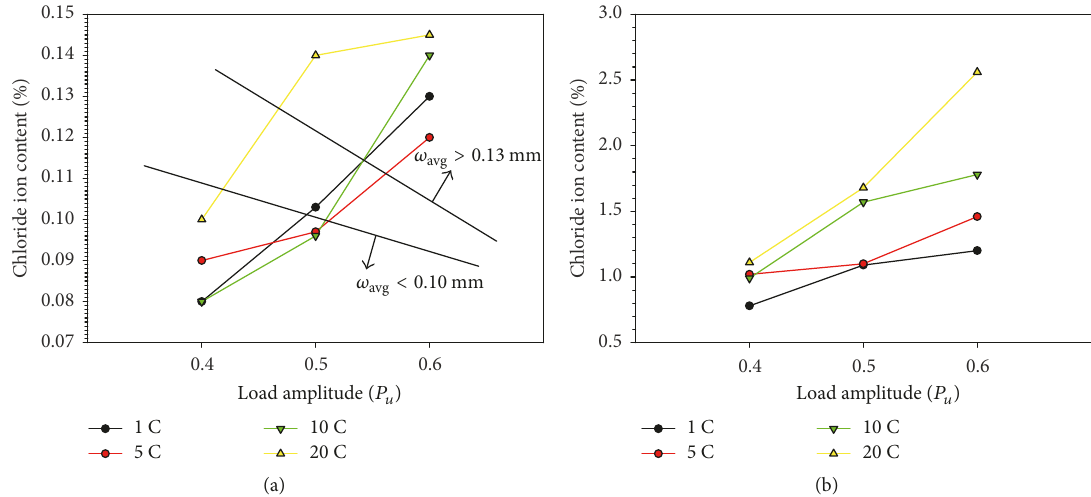
Figure 8: (a) Chloride ion content with load amplitudes and cycle numbers at steel depth. (b) Accumulation chloride ion content in tensile concrete